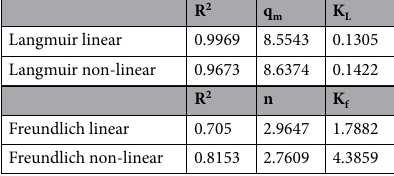
Table 3. Isotherm constants for the biosorption onto Eclipta alba